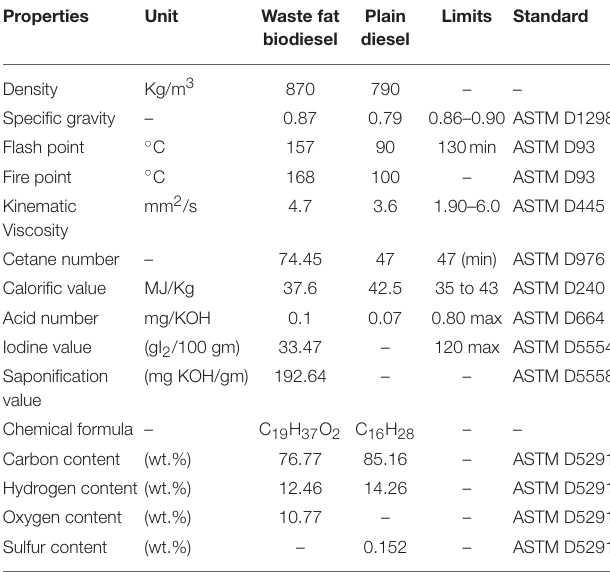
TABLE 2 | Physico-chemical properties of waste animal fat biodiesel.